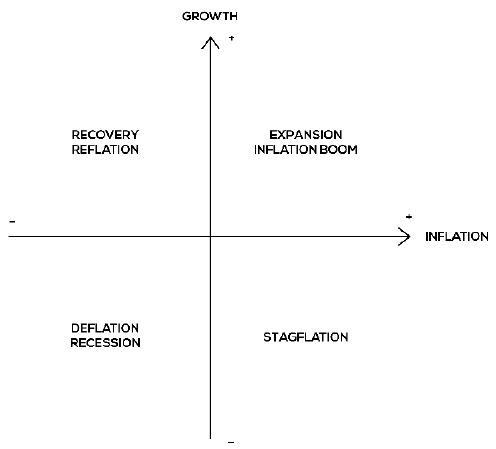
Figure 1. Quadrant of the macroeconomic scenario. Source: authors’ elaboration. Table 1. Relation between the asset classes, trends, and macroeconomic conditions.